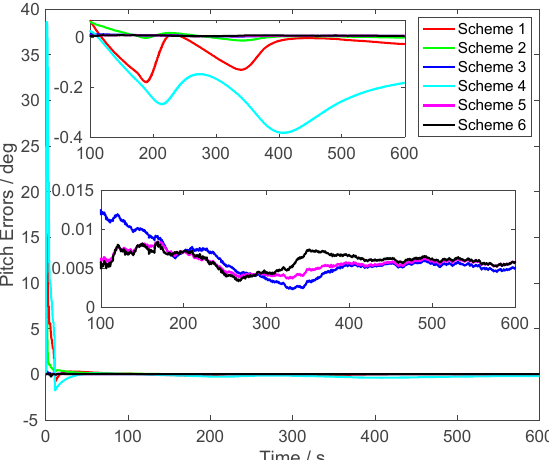
Figure 2. The in-motion status of the vehicle.